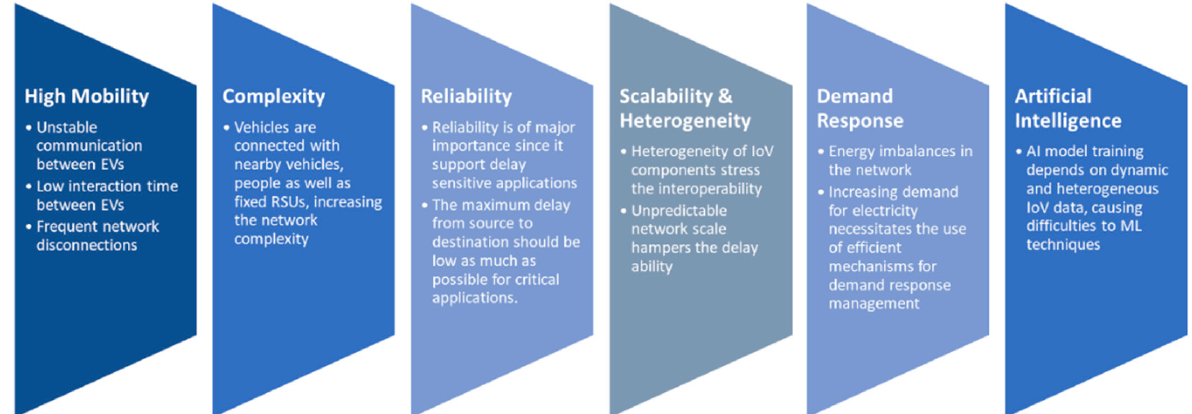
Figure 10. Challenges of IoV-assisted smart grids.